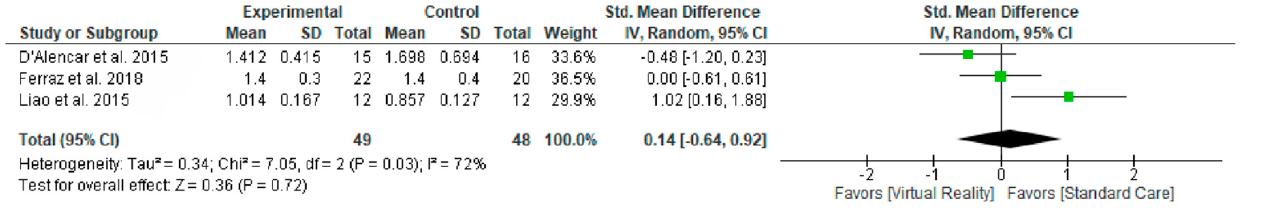
Figure 4. Comparison 1. Virtual reality versus standard care treatment. Outcome: gait speed. A green block indicates the weight assigned to the study, and the horizontal line depicts the confidence interval. A black rhombus shows the overall result [36,37,39].